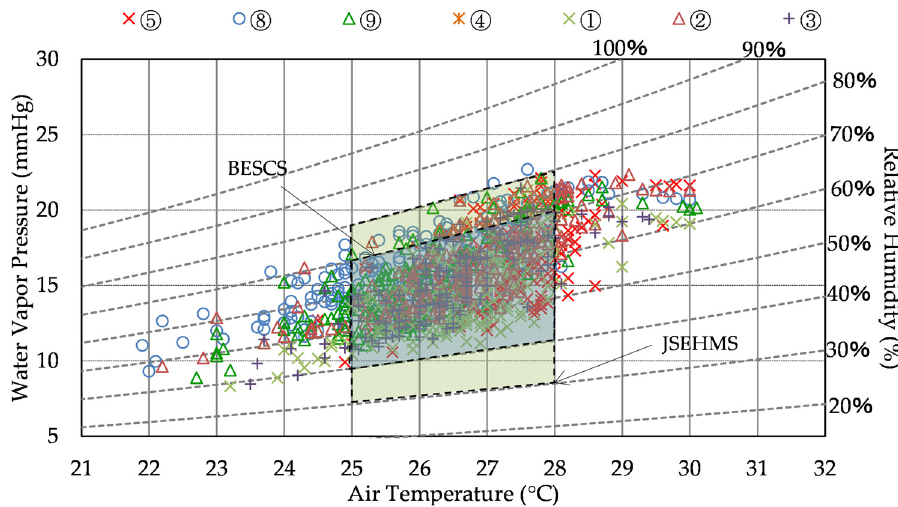
Figure 13. Summer psychometric chart for class B.